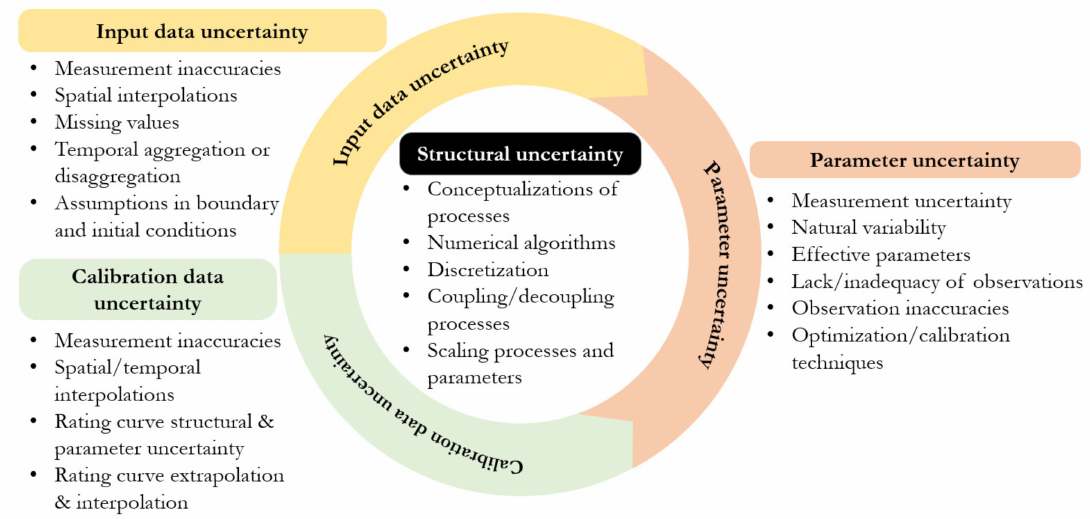
Figure 3. The different sources of hydrological model uncertainty and examples of their